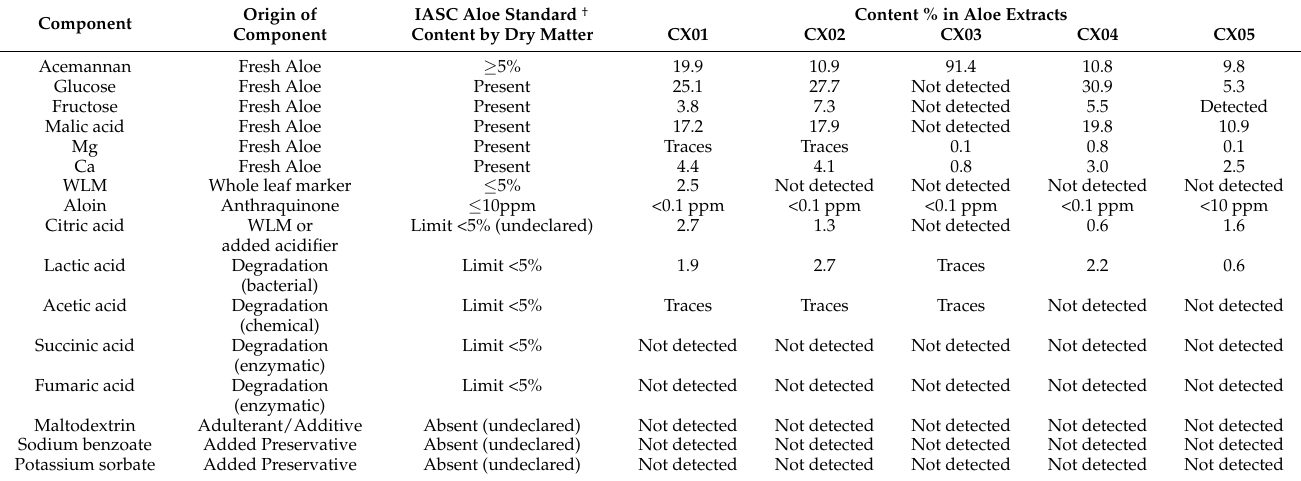
Table 2. Standard phytochemical quality characteristics of Aloe gel extracts used in the